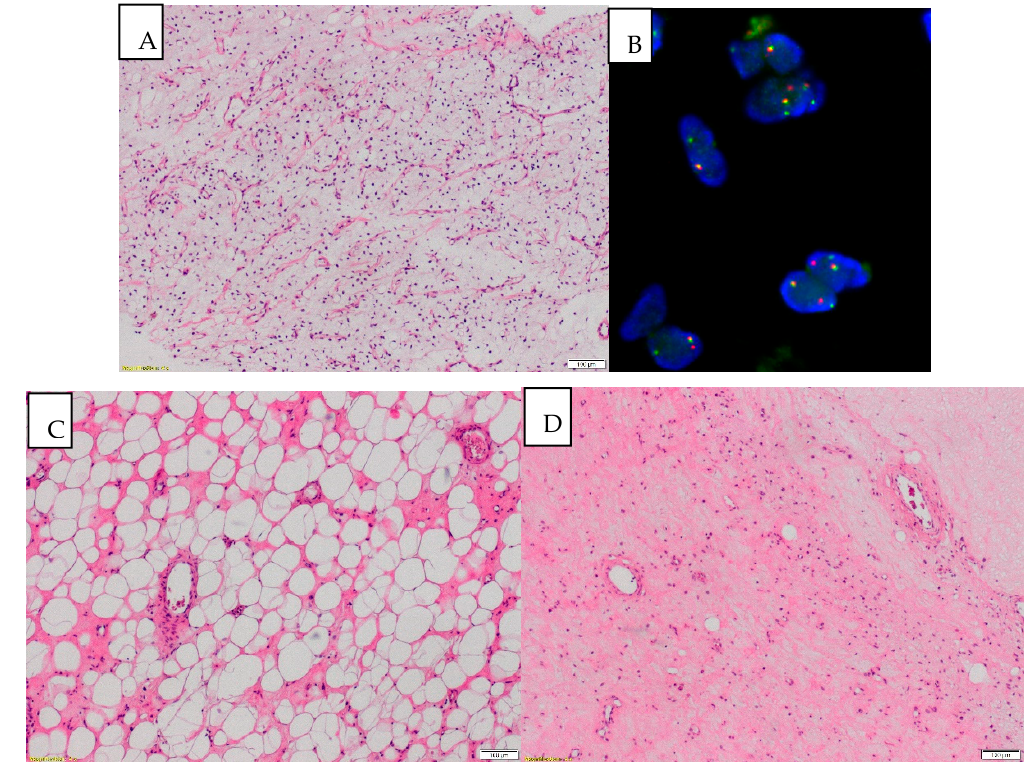
Figure 3. ( A ) MLPS (myxoid liposarcoma) before treatment: paucicellular, monomorphic, myxoid tumor with plexiform vasculature and scattered signet ring lipoblasts (magnification 40×). ( B ) Rearrangement of the DDIT3 gene detected on the FISH analysis. ( C ) After treatment: striking lipomatous differentiation induced by RTH can be a predominant pattern after treatment (magnification 40×), ( D ) After treatment: diminished cellularity, stromal fibrosis, reduced vasculature with thickened blood vessel walls and tumor infiltrating macrophages (TAM). Area of necrosis in the right upper corner (magnification 40×).